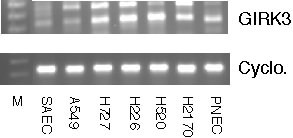
GIRK3 expression in NSCLC cell lines and in normal cells. Top panel: GIRK3 was expressed in normal human SAEC and hamster PNEC as well as being expressed in all NSCLC cell lines tested. These NSCLC cell lines are: A549, H727, H226, H520, and H2170. Bottom panel: Cyclophilin, used as a positive reaction control was seen in all samples. For all gene expression experiments, negative control reactions were performed and found to be negative. The bands on the agarose gels were consistent with the expected sizes: GIRK3-317 bp; cyclophilin-216 bp; M-100 bp.